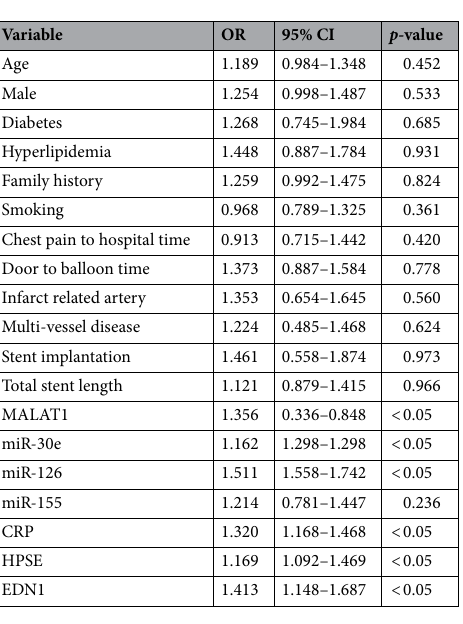
Table 3. Logistic regression analysis of reflow-related features of STEMI patients.